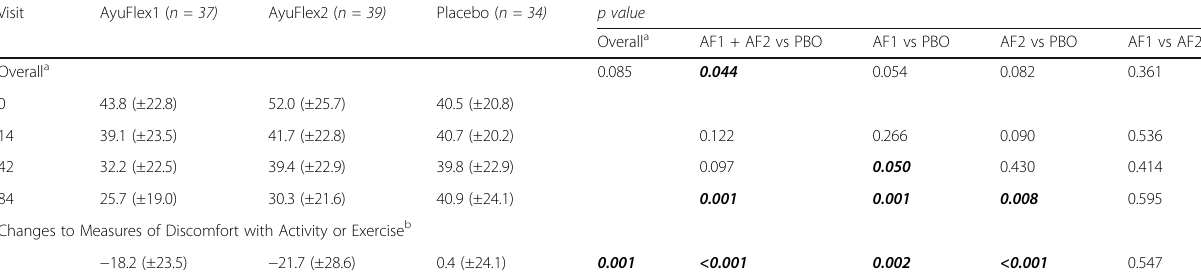
Table 6 VAS score of measure of discomfort with activity/exercise